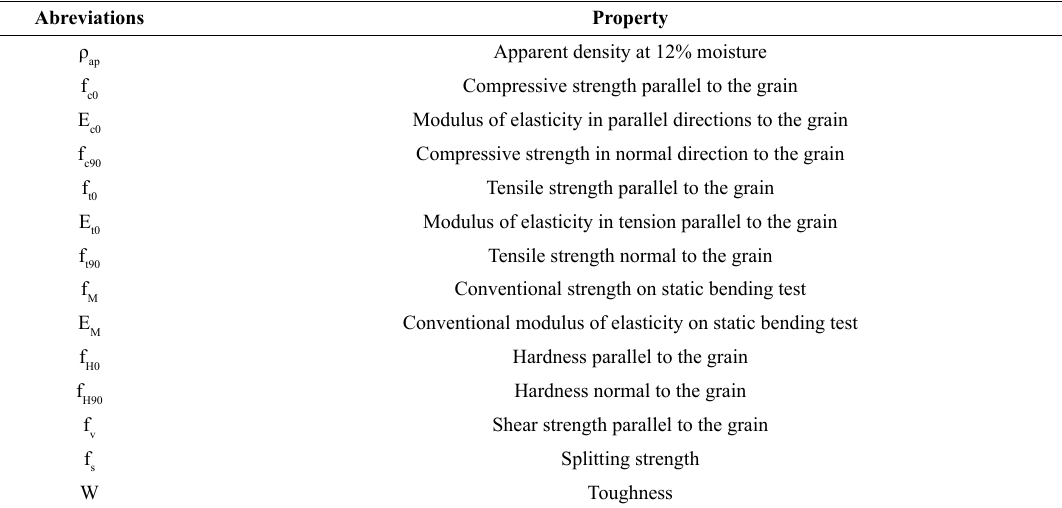
Table 2. Properties